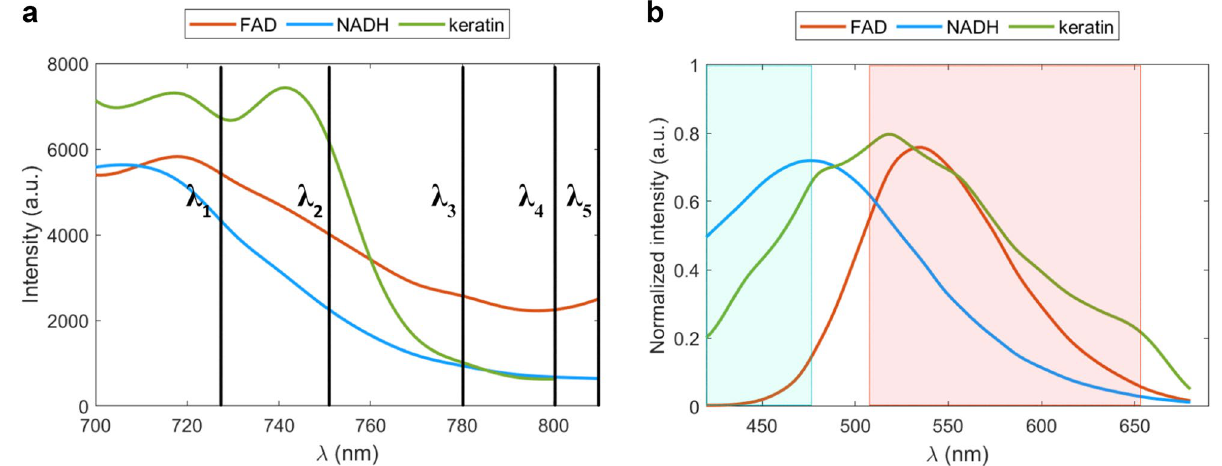
Figure 1. Two-photon excitation and emission spectra of the fluorophores in solution. ( a ) Excitation spectra of FAD (orange), NADH (blue), and keratin (green) in the excitation range of 700–820 nm. The excitation wavelength chosen for the study: λ 1 —725 nm, λ 2 —750 nm, λ 3 —780 nm, λ 4 —800 nm, and λ 5 —810 nm. ( b ) Normalized emission spectra of FAD (orange) and NADH (blue) excited at 720 nm, and keratin (green) excited at 700 nm. The range of the filters used is indicated by the blue- and red-shaded